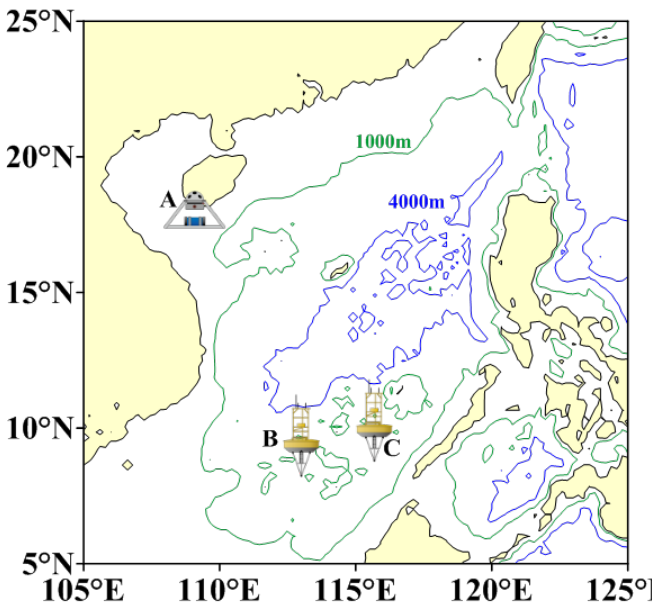
Figure 1. Topography of the South China Sea and the locations of three observation sites (A, B, and C) in this study.